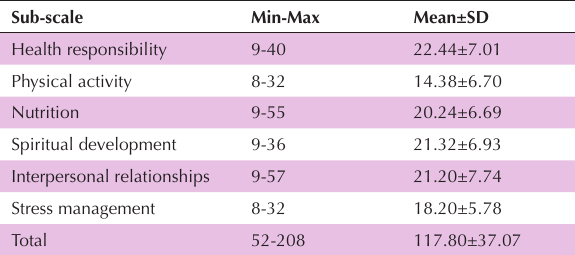
Table 1. Distribution of HPLP II and sub-scale